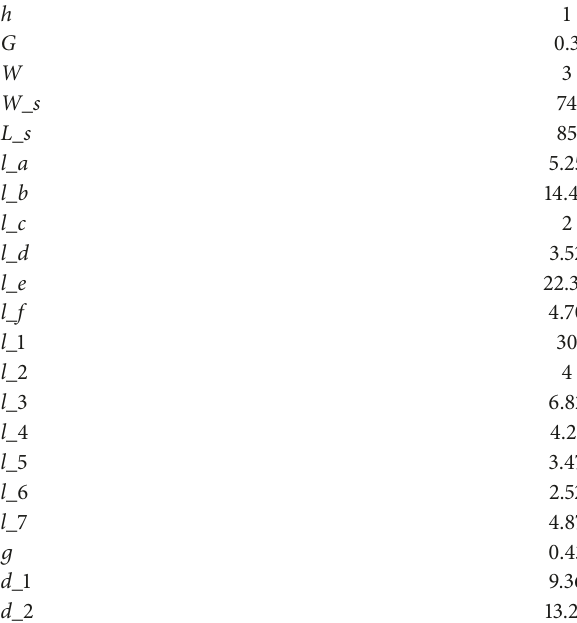
Table 3: The optimal parameters of the 2 × 2 array (unit: